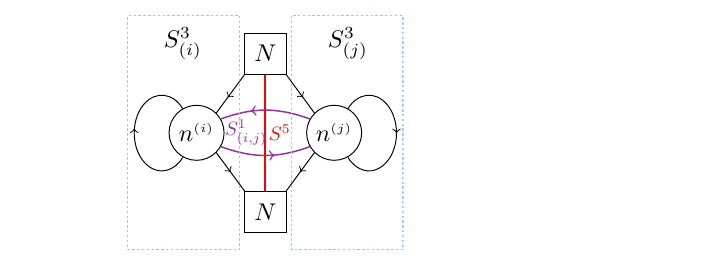
Figure 2. Here we depict part of the full quiver description of the intersecting gauge theory, where we include only the two 3d SQCDA’s on S 3 and S 3 coupled to the 1d bi-fundamental chirals on the ( i ) ( j ) intersection S 1 . For the full quiver one simply repeat this patter for all three pairs of 3d theories. The ( i , j ) purple arrowed lines denote the 1d bi-fundamental chiral multiplets supported on the intersection S 1